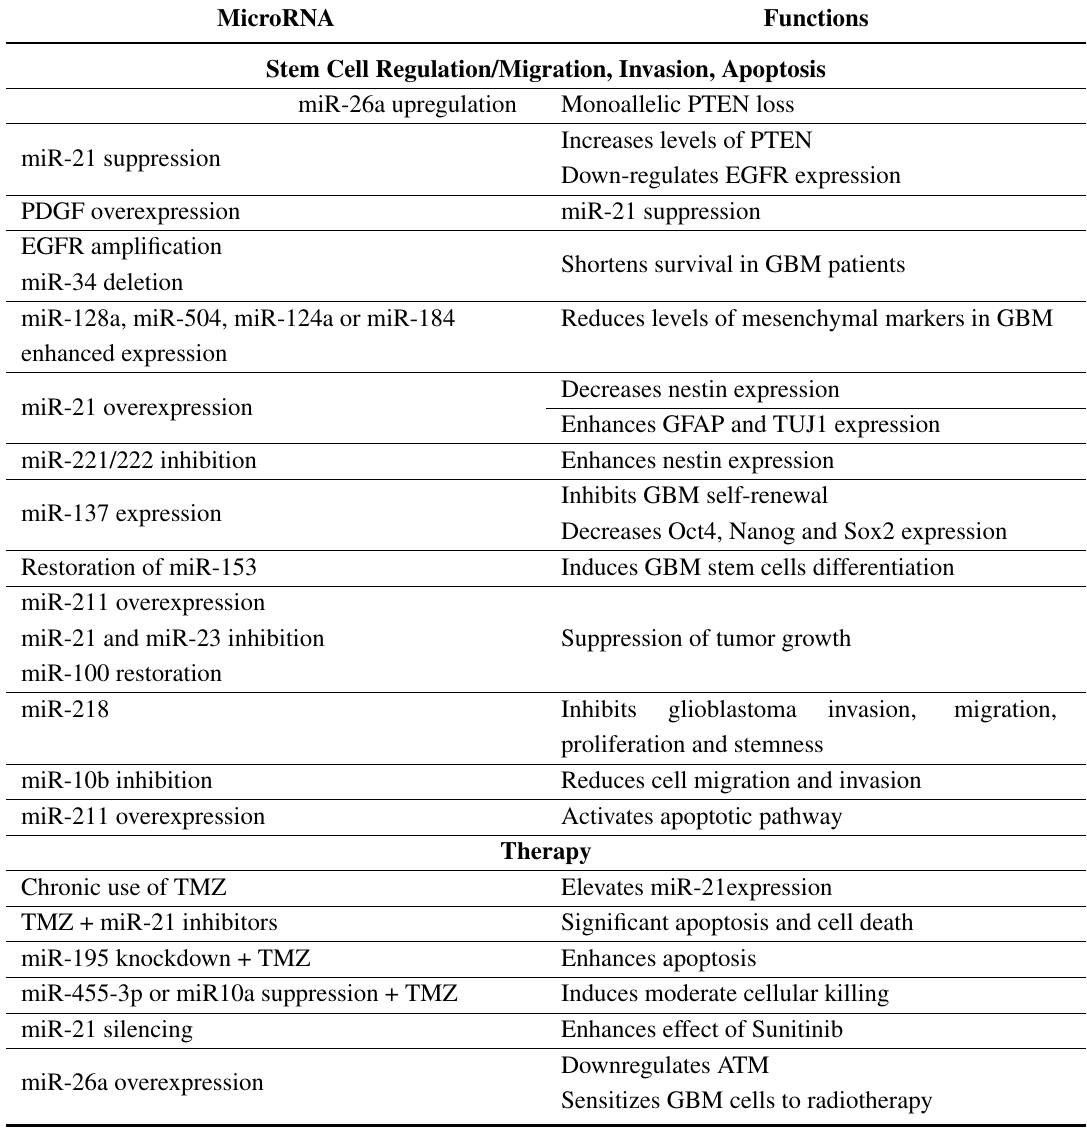
MicroRNA in regulation of GBM stem cells and other functions. TMZ,